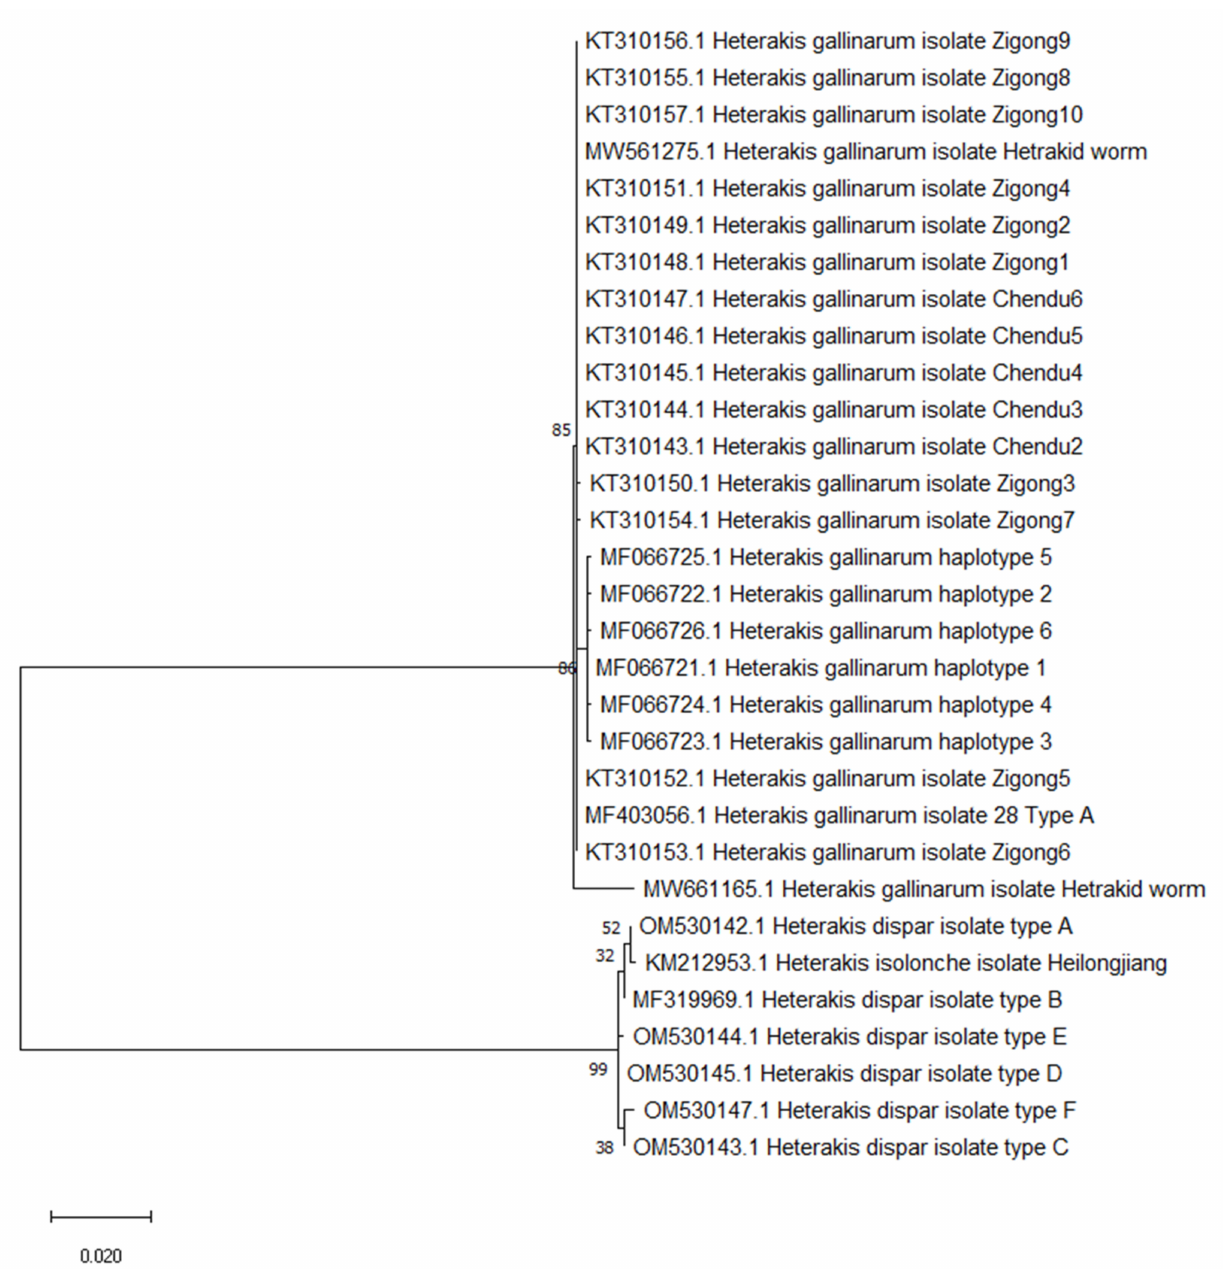
Figure 2. Phylogenetic tree interrelationships among poultry Heterakis spp. on maximum likelihood method with 1000 bootstrap randomizations of partial ITS1-5.8S2-ITS2 sequence (888 bp). The scale bar indicates the number of substitutions per